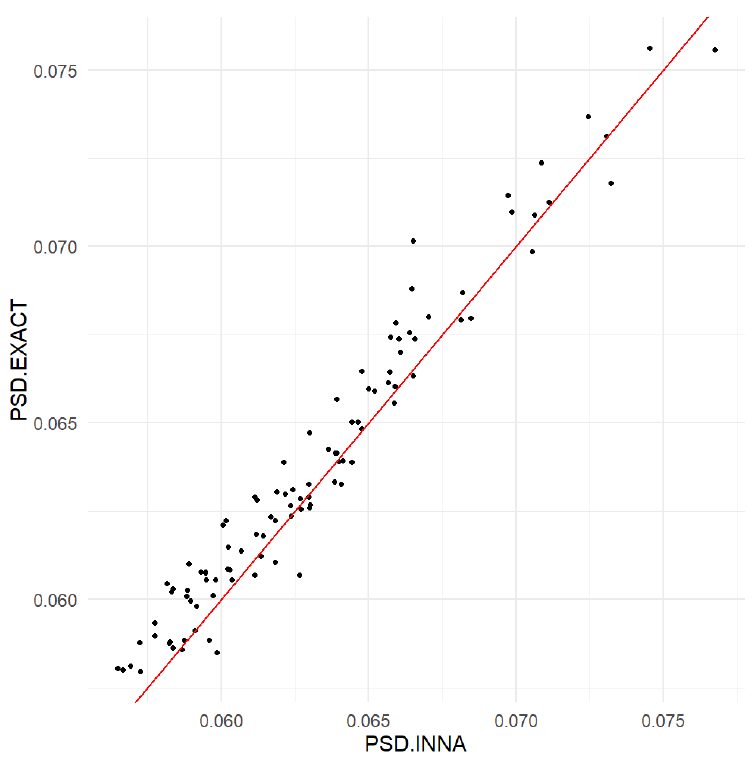
Figure 5. Comparison of the INNA method and the exact method using the PSDs of the ward